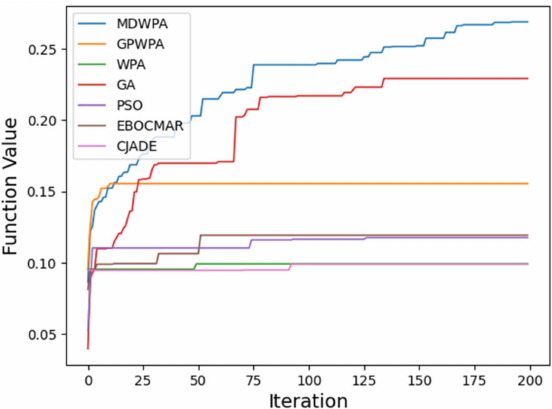
Figure 8. Comparison of iterative curves of algorithms on test cases